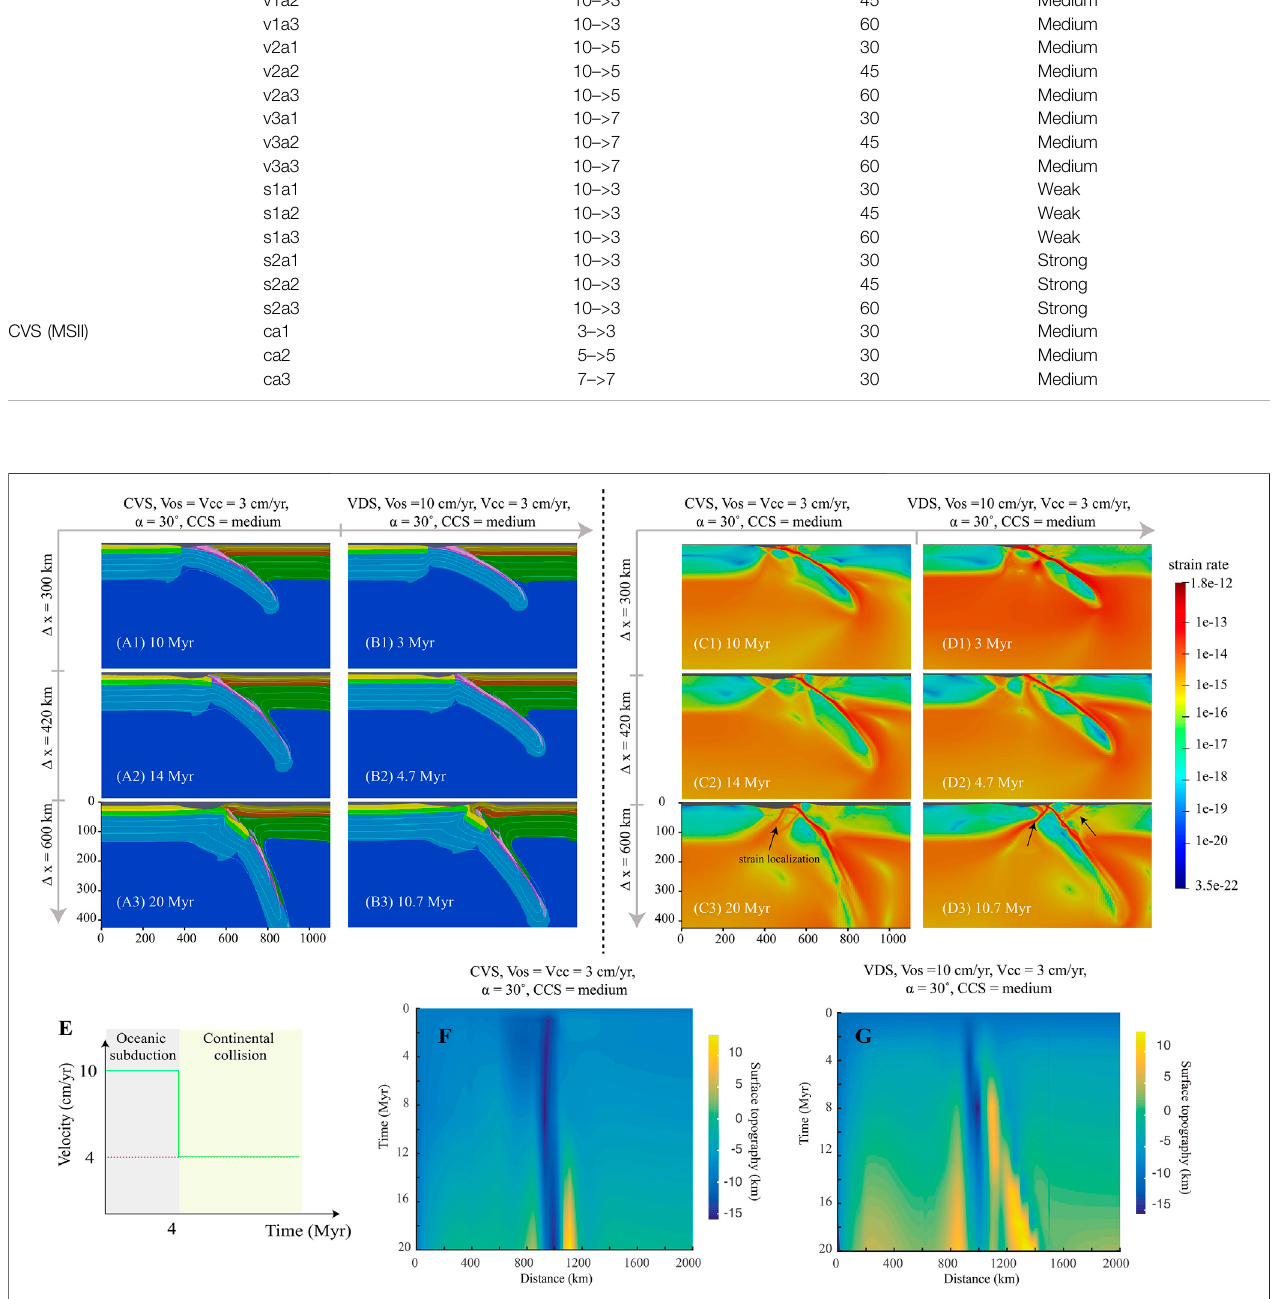
Frontiers in Earth Science |